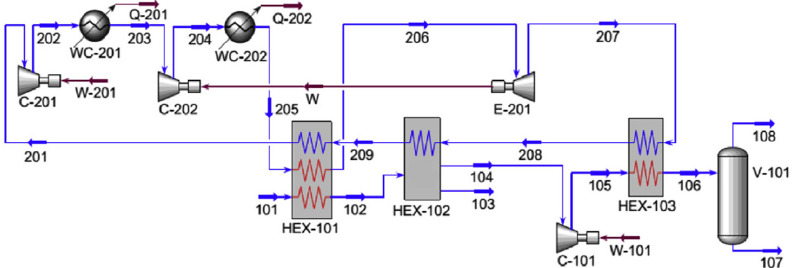
Figure 56. The proposed process without precooling [208]. Reproduced with permission from